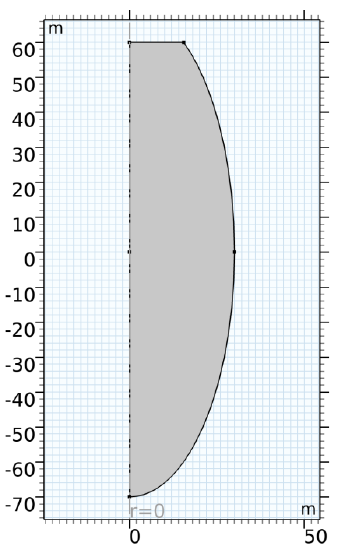
Figure 9. Models with different shapes.